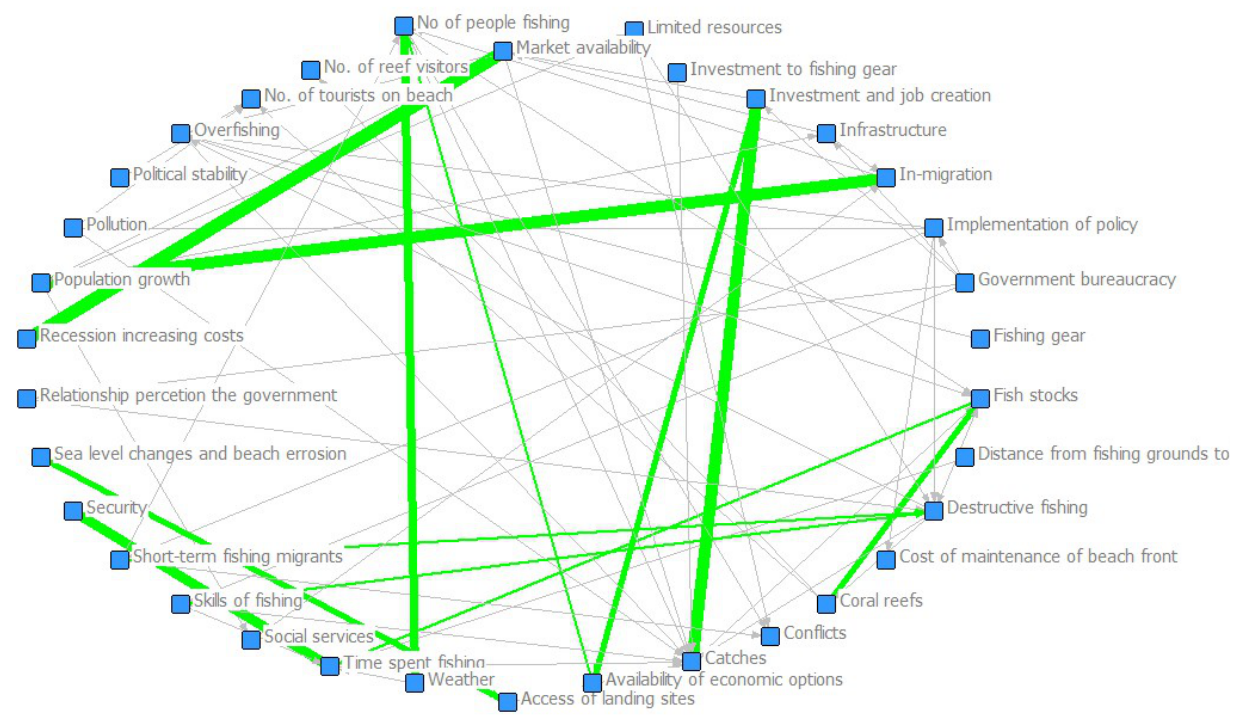
Figure S4. Links thickness represent degree of